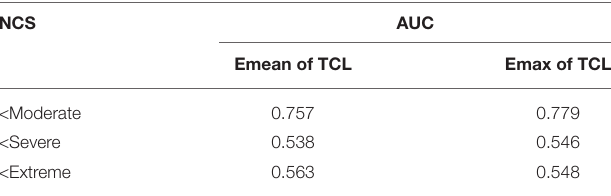
TABLE 5 | The AUC and cut-off value for TCL stiffness at the DCT for diagnosing the severity of